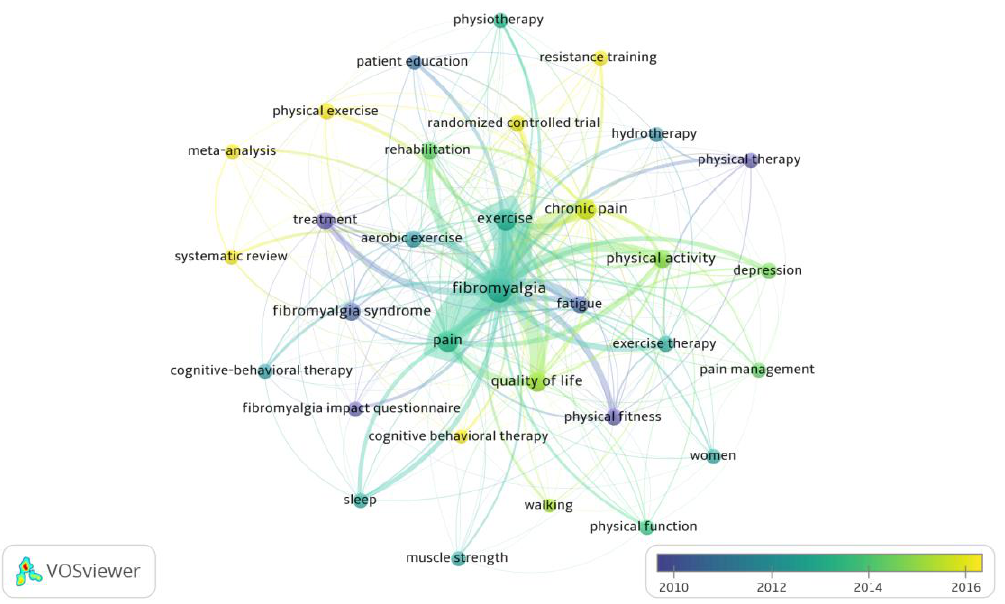
Figure 8. Documents with most frequently used author keywords by average year of publication.